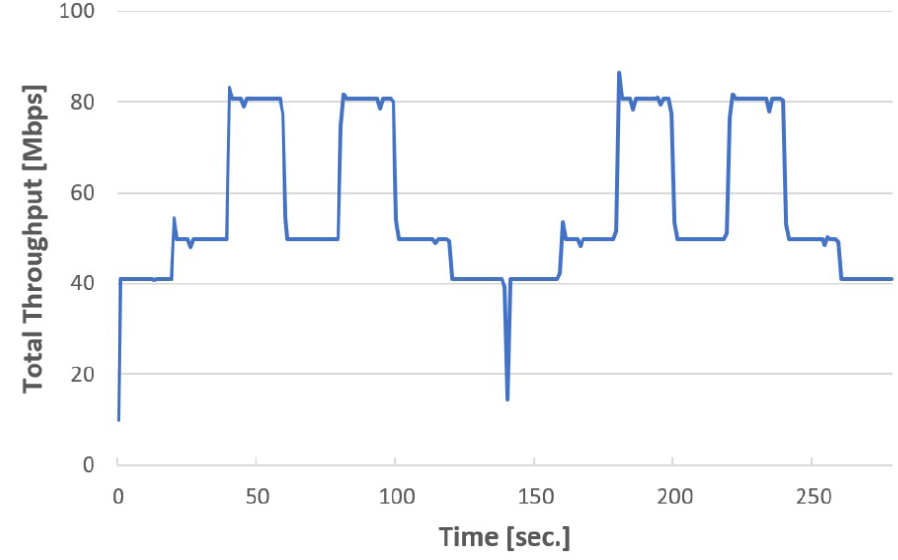
Figure 3. Total throughput without AI.